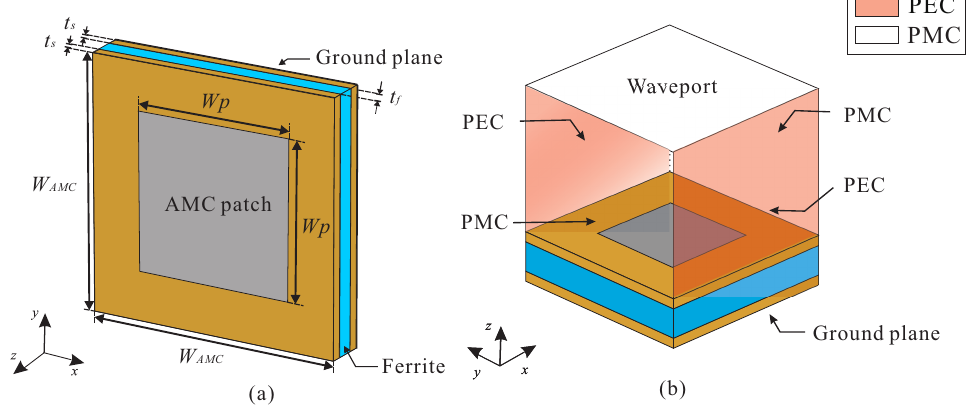
Figure 1. Configuration of the proposed unit cell of the AMC: ( a ) perspective-view; ( b ) boundary